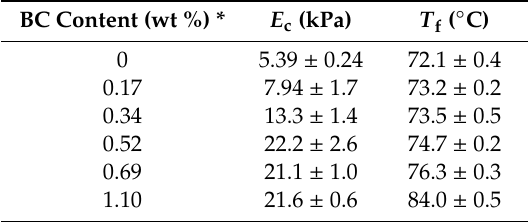
Table 2. Influence of BC content on compression modulus of elasticity ( E c ) and on fusion temperature ( T f ) of PVA-CG and PVA-CG/BC composites.